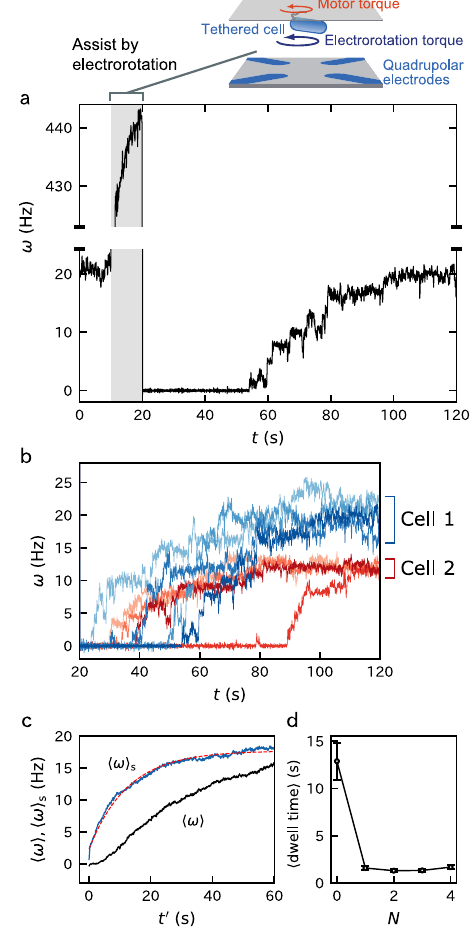
Fig. 2 Rotation traces. a A typical rotation trace of the remodeling process. After the initial 10-s phase, a strong assisting torque was applied for 10 s for releasing the stator units from the motor by the electrorotation method 20 . ω > 0 corresponds to the counter-clockwise (CCW) direction. b Consecutive traces of two motors (blue and red) are superposed. Different colors correspond to different runs. See Supplementary Fig. 2 for the separate plots of these cells for the comparison. c Ensemble average speeds of remodeling traces, plotted against time after electrorotation stopped ( t 0 ¼ t (cid:2) 20 s, 〈 ω 〉 , black) and against time after the fi rst stator is stably incorporated ( t 0 ¼ t (cid:2) t 1 , 〈 ω 〉 s , blue). Forty traces were averaged, see text for the de fi nition of t 1 . Forty traces were averaged. For 〈 ω 〉 , the time origin was reset to t 0 ¼ 0. 〈 ω 〉 s was fi tted by h ω i s ¼ ω ss ð 1 (cid:2) e (cid:2) kt 0 Þ þ ω 1 e (cid:2) kt 0 with the fi tting parameters of k = 0.080 s − 1 and ω ss = 18s − 1 (red dashed curve). ω 1 was approximated by ω max = 10. d The mean dwell time at each N obtained by the step analysis of the above 40 traces (Supplementary Fig. 3). Data are presented as mean values ± standard errors. The number of dwells are 63, 87, 90, 104, and 135 for N = 0, … , 4,